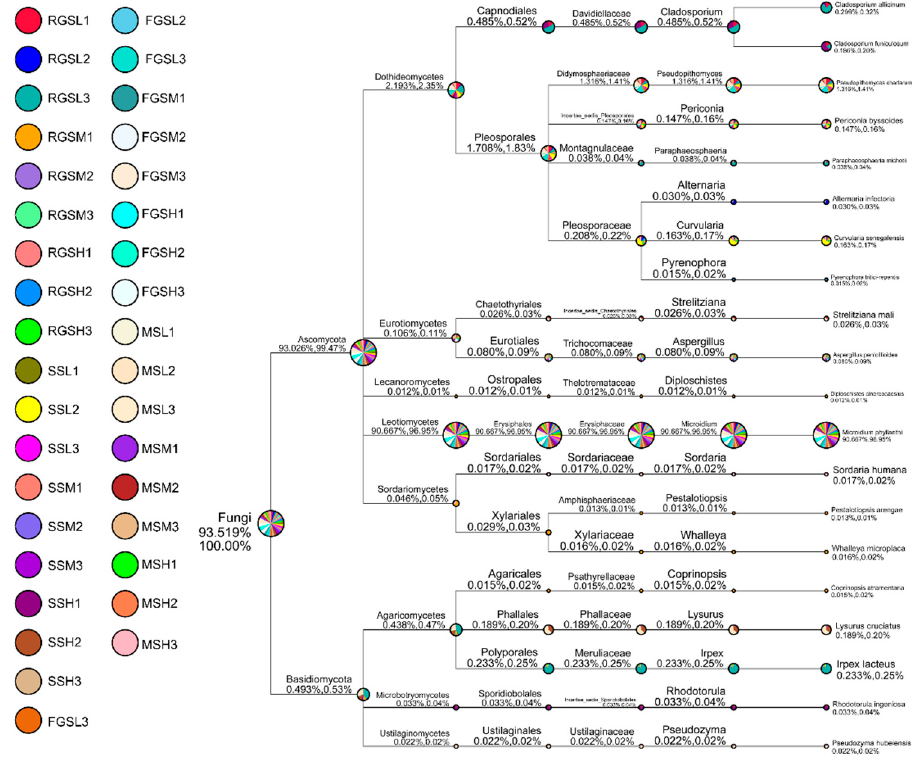
Figure 1. Taxonomic tree of all samples. Taxonomic tree of fungal communities of healthy tobacco plants at four growth stages (seedling (SS), resettling growth (RGS), fast-growing (FGS), and maturing (MS)).